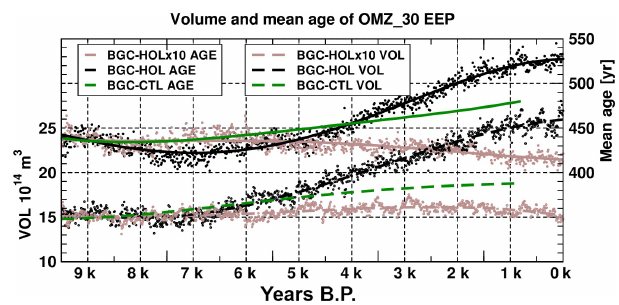
Figure 12. Time series of EEP OMZ volume for a threshold of 30µmolL − 1 in 10 14 m 3 (left axis, lower dashed curves) and mean age of water mass in the EEP OMZ in years (right axis, upper solid curves). EEP defined as 140–74 ◦ W, 10 ◦ S–10 ◦ N, 0–1000m depth. Circles represent annual mean values of the OMZ volume, and dots are annual mean values of the water mass age in the EEP OMZ for BGC-HOL (black), BGC-HOLx10 (brown), and BGC- CTL (green). Solid lines represent polynomial fits of fourth